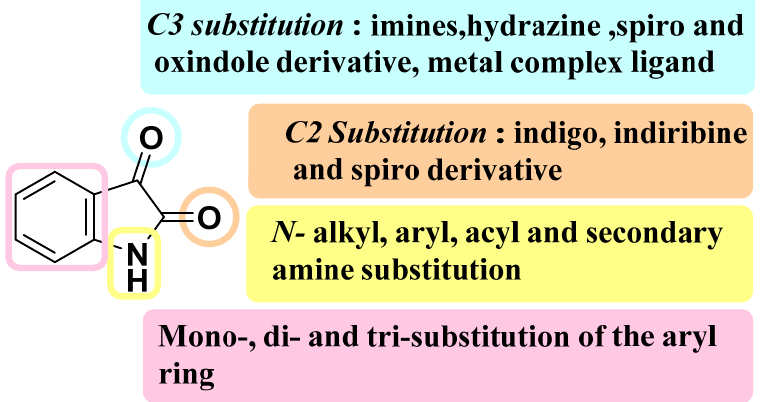
Figure 1. Probable substitution possible on isatin nucleus.